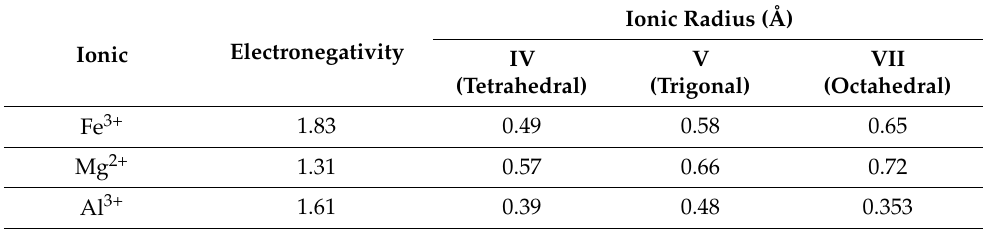
Ionic Radius (Å) IV V (Tetrahedral) (Trigonal)